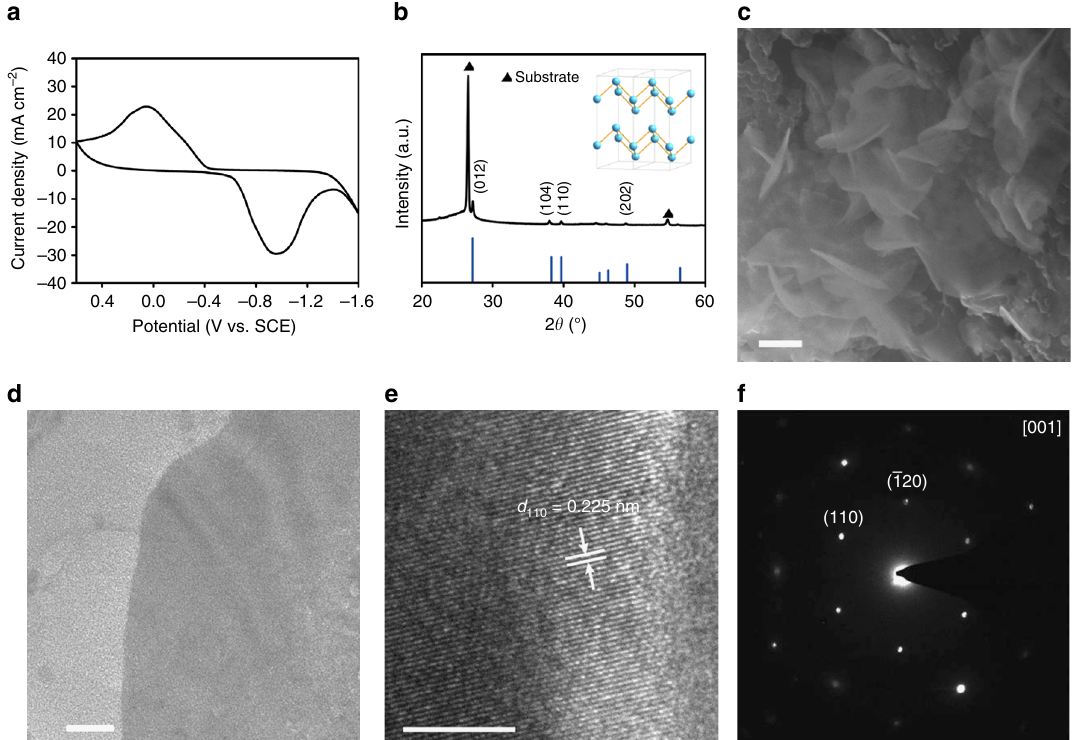
Fig. 2 Structural characterizations of topotactically reduced BiNS. a CV curve of BiOI showing its reduction to metallic Bi at cathodic potentials; b XRD and (inserted) schematic crystal structure of Bi; c SEM image; d , e TEM images at different magni fi cations; f SAED pattern of BiNS. Scale bar, 200 nm ( c ); 20 nm ( d ); 5 nm ( e